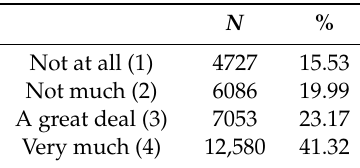
Table 3. Distribution of frequencies relating worries on terrorist